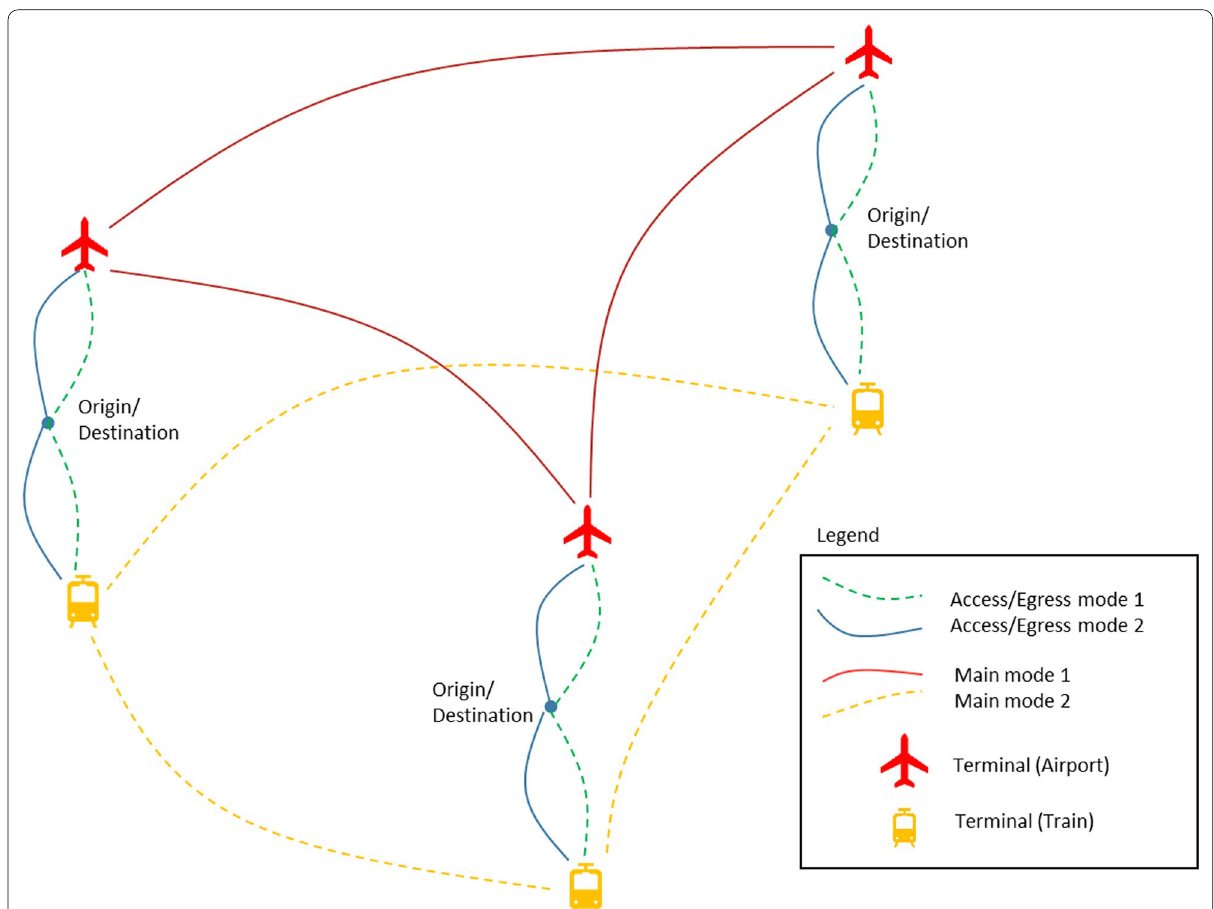
Fig. 7 Schematic figure of access/egress mode choice within main mode and destination choice (Type